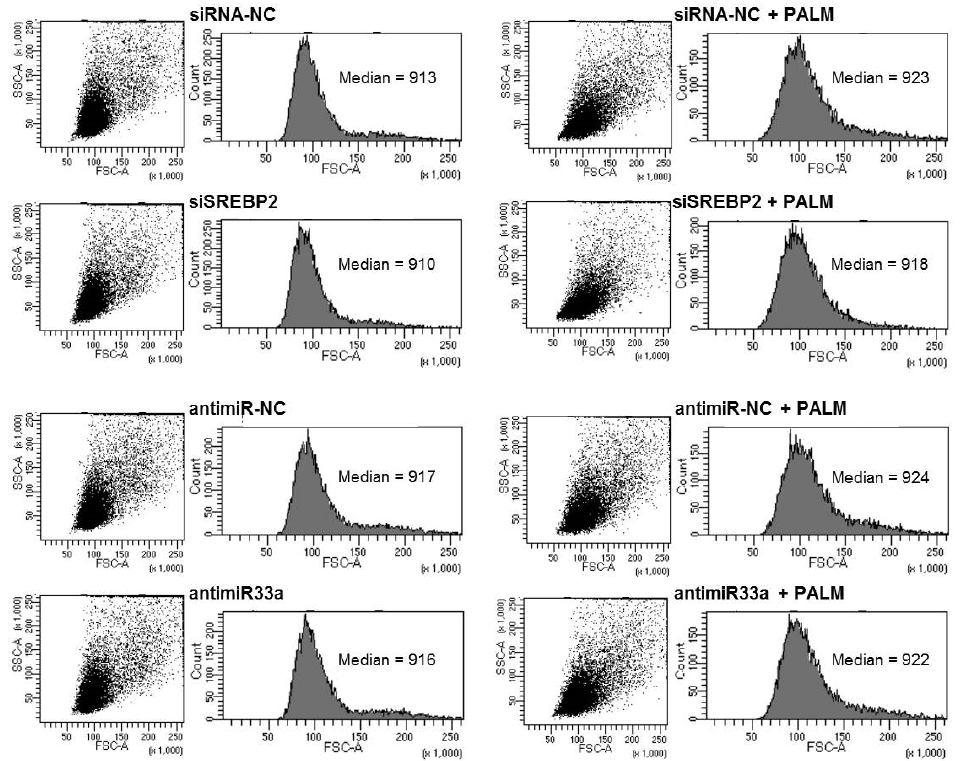
Figure 7. Effect of SREBP2 and miR33a silencing on cell size after palmitate treatment. H9c2 cells were transfected for 24 h with SREBP2 siRNA or antimiR33a. After 16 h of incubation with or without palmitate, cells were fixed and analyzed in a flow cytometer by measuring the forward scattering (FSC).